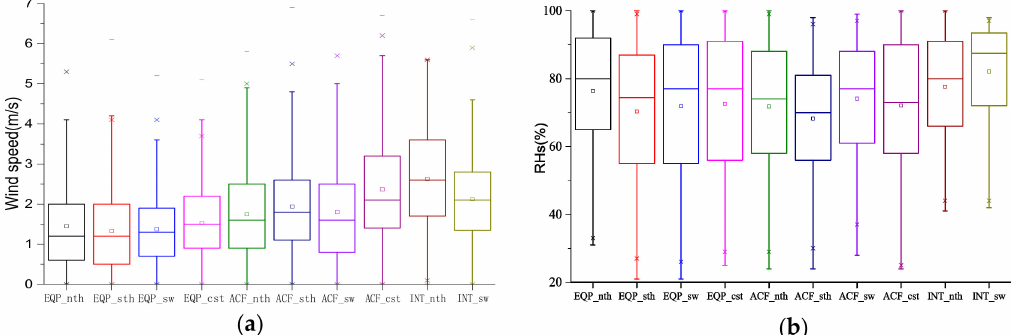
Figure 7. Wind speed ( a ) and RHs ( b ) on RPHPDs (regional PM 2.5 pollution days) under the ten types. Rectangle: 25%–75% (quartile); rectangle midline: the median; end of the line: 5%–95%; × : 1% and 99%; (cid:3) :